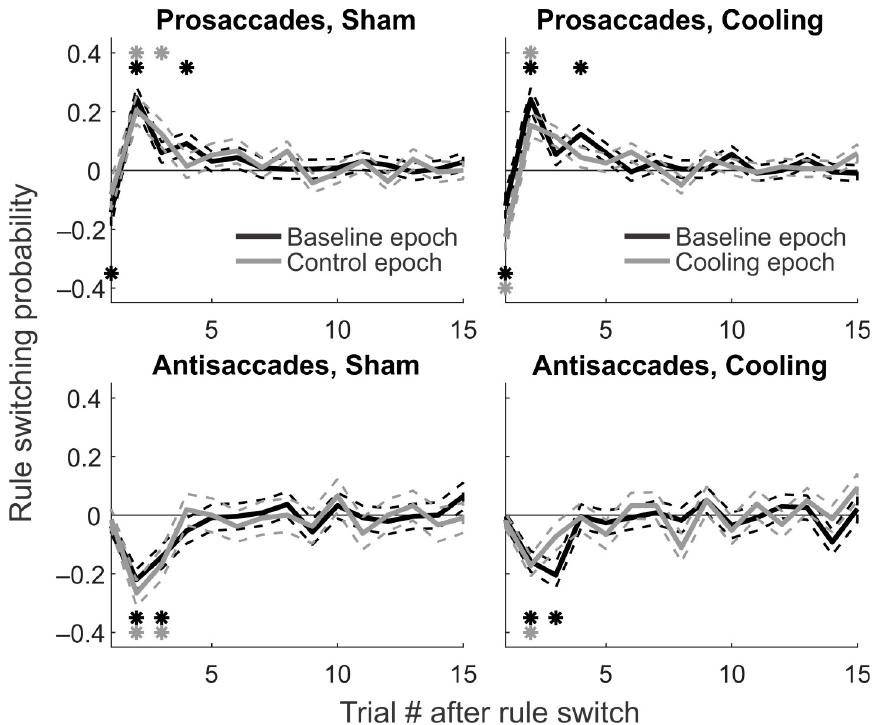
Fig 3. Signed rule-switching probability under either rule (top versus bottom row) in cooling or sham sessions (left versus right column) during baseline (black curves) and control/cooling epochs (gray curves). Asterisks indicate significantly positive or negative switching probability in the curve with the same color. Positive switching probability indicates that a switch from antisaccade to prosaccade rule often occurred from the previous trial to the current one. Negative switching probability indicates that a switch in the opposite direction often took place. Top left: in sham sessions, switching from the antisaccade to the prosaccade rule usually took place between the second and fourth trial post switch. Toward the end of an antisaccade trial block, the animals often tested the prosaccade rule and then switched back to antisaccades, as reflected in the negative switching probability in the first post-switch trial. Top right: similar pattern was observed in cooling sessions. Cooling did not disrupt or delay the switch from antisaccades to prosaccades. Bottom left: in sham sessions, switching from the prosaccade to the antisaccade rule usually took place in the second or third trial post switch in both the baseline (black) and control (gray) epochs. Bottom right: cooling did not disrupt or delay the switch from prosaccades to antisaccades. Thus, significant rule switches were completed within the first 4 trials of a new block of either prosaccade or antisaccade trials, which we termed the Early stage. Data associated with this figure can be found at 10.6084/m9.figshare.8236589.